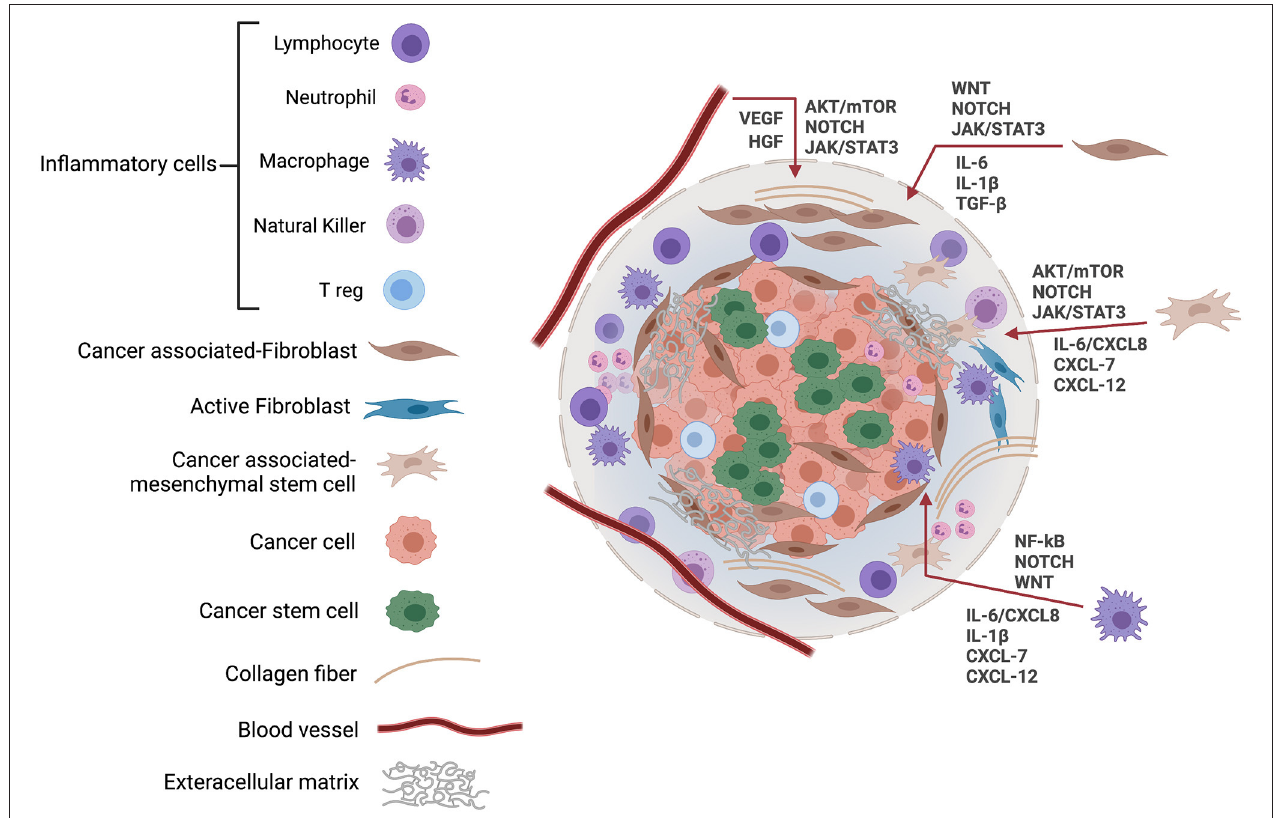
FIGURE 1 | The cancer stem cell microenvironment. The niche or tumor microenvironment is essential for maintenance of stemness, and this also applies to CSCs where cell–cell interactions within the niche are required to support the role of CSCs in cancer initiation and progression. The CSC microenvironment also contributes to CSCs’ resistance to drugs and other cancer therapies, thereby, promoting cancer recurrence. The tumor tissue microenvironment is composed of a variety of cells, including tumor cells, cancer stem cells, inflammatory cells, and cancer-associated fibroblasts, along with blood vessels and extracellular matrix. In response to hypoxic stress and matrix, CSCs induce growth factors and cytokines including IL-6, CXCL8, and VEGF to regulate their growth via EGFR, NOTCH, WNT, and other signaling cascades. JAK, Janus kinases; STAT, signal transducer, and activator of transcription; VEGF, vascular endothelial growth factor; HGF, hepatocyte growth factor; mTOR, mammalian target of rapamycin; IL, Interleukin; CXCL, CXC-motif chemokine